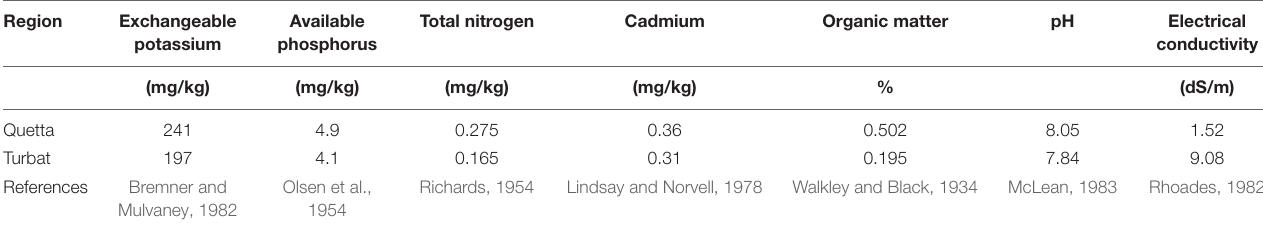
TABLE 1 | Physio-chemical analysis of the soil of experimental sites.